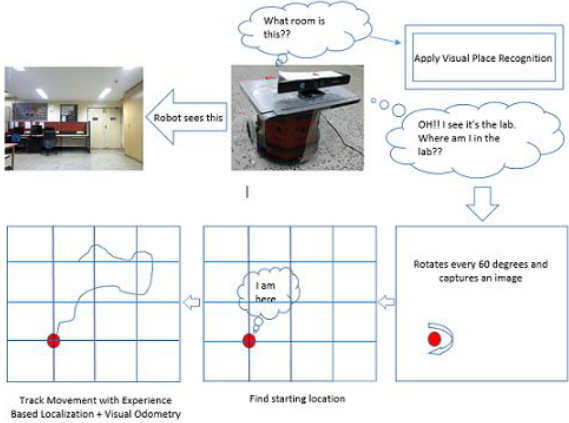
Figure 1: Project Overview: This figure shows the entire process of the project approach starting with visual place recognition, fol- lowed by finding the starting point and experience based localiza- tion operating in parallel with visual